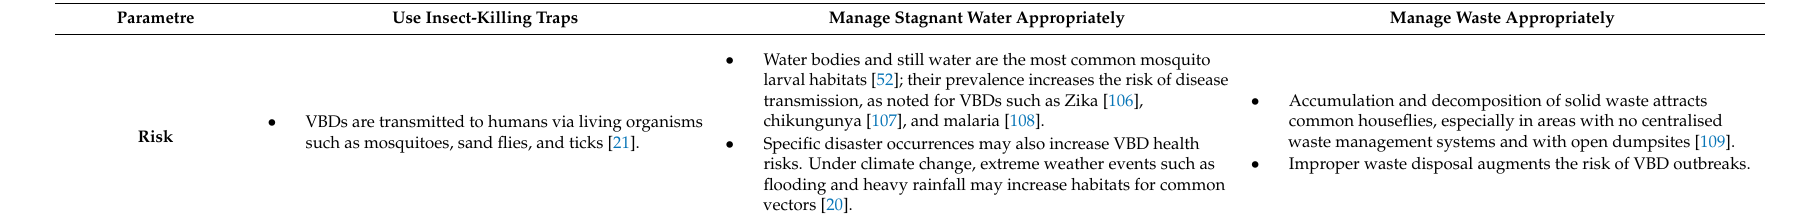
Table 3. Environmental Management Practices as Health-EDRM Primary Prevention Approaches against